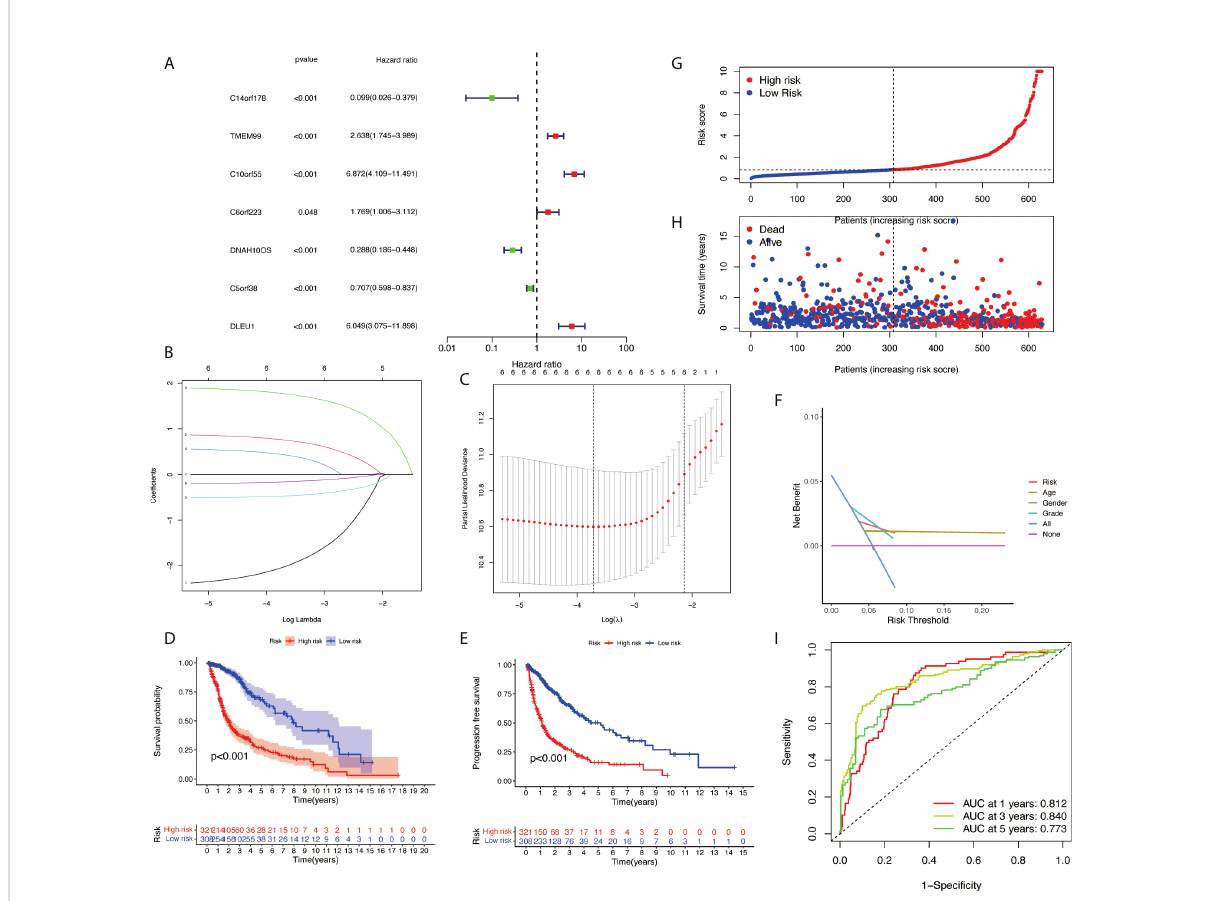
FIGURE 3 Development of necroptosis-related lncRNA (NRlncRNA) prognosis signature. (A) Univariate Cox regression analysis of glioma for each prognostic NRlncRNA. (B) Distribution of LASSO coef fi cient for prognostic NRlncRNAs. (C) Partial likelihood deviance of the LASSO coef fi cient distribution. (D) Overall survival curves for glioma patients in the high-/low ‐ risk group. (E) PFS curves for glioma patients in the high-/low ‐ risk group. (F) DCA curves for glioma patients based on clinical information. (G) Distribution of GBM patients based on the risk score. (H) Distribution of GBM patients based on survival status. (I) ROC curves of measuring the predictive value. LASSO, least absolute shrinkage and selection operator; PFS, progression-free survival; DCA, decision curve analysis; GBM, glioblastoma multiforme; ROC, receiver operating